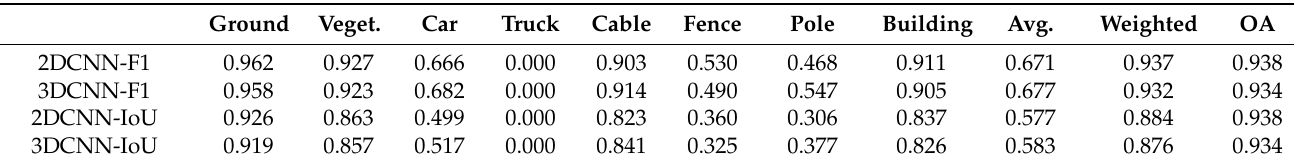
Table 8. Average and weighted F1 and IoU scores for 2DCNN and 3DCNN classifiers on the DALES dataset. The OA is also reported.